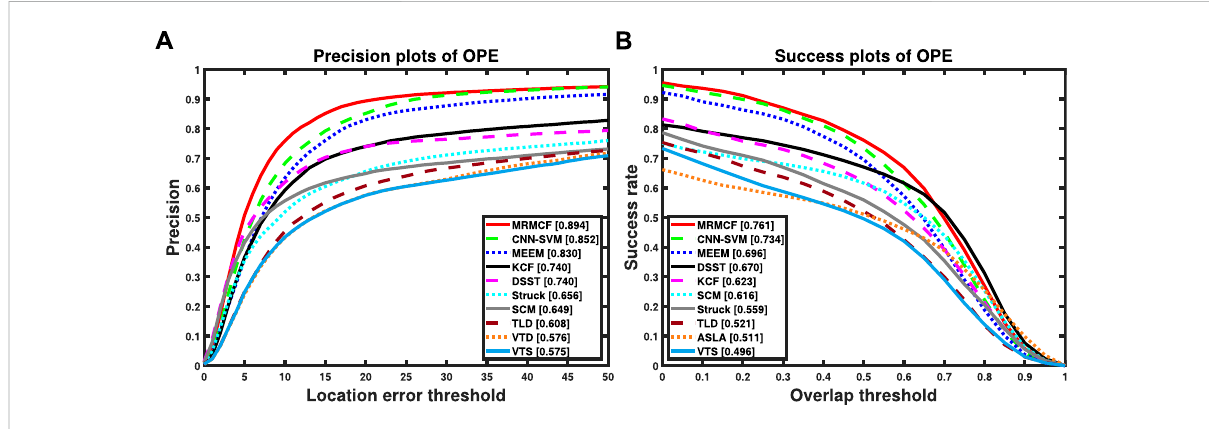
FIGURE 4 OPE comparison results of the proposed tracker and the comparison methods on OTB50. (A) Precision plots, (B) Success